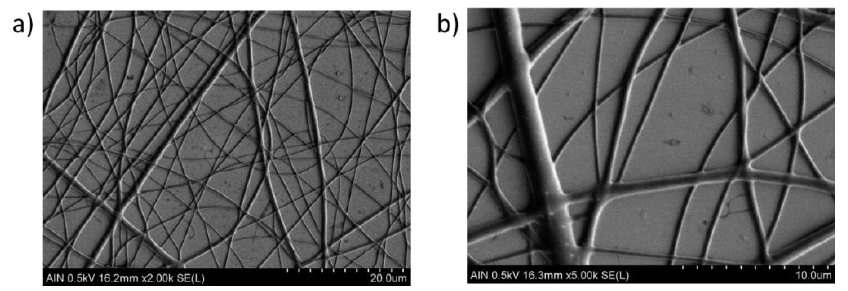
Figure 5. The SEM images of PAA + β-CD + TiO 2 NPs with a scale bar of 20 µm ( a ) and 10 µm ( b ), respectively.